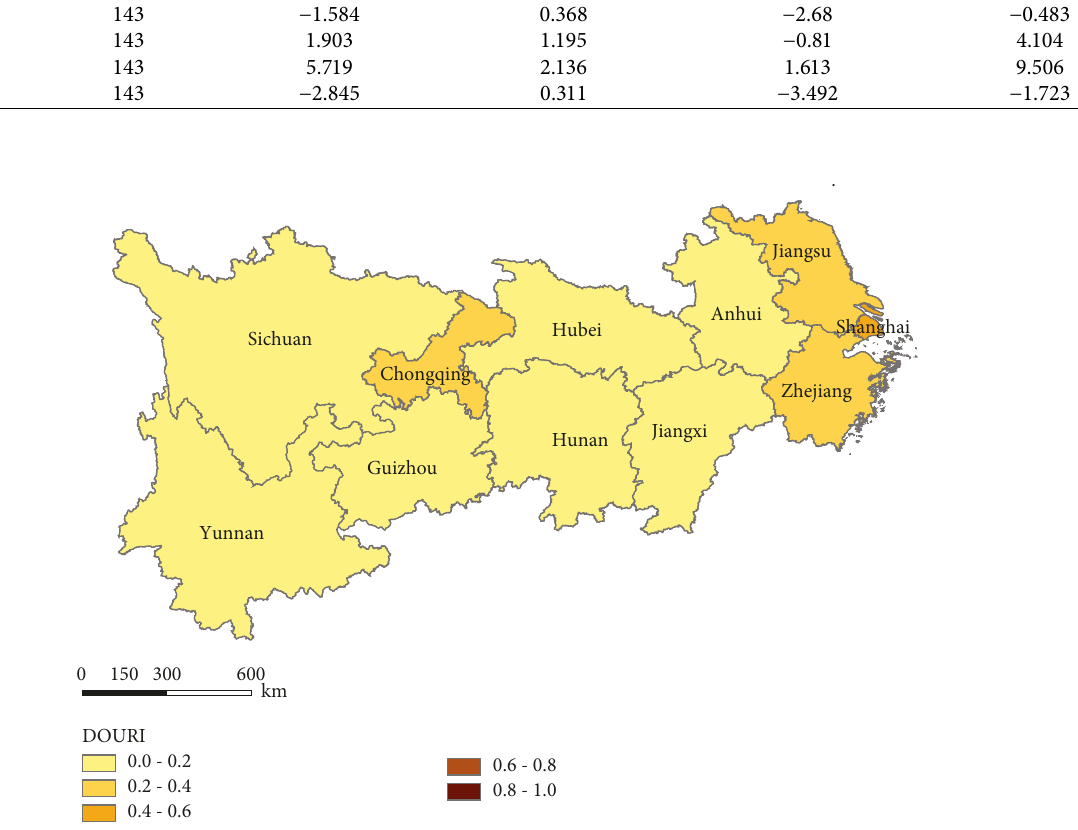
Figure 1: Spatial distribution map of the urban-rural integration degree of the Yangtze River Economic Belt in